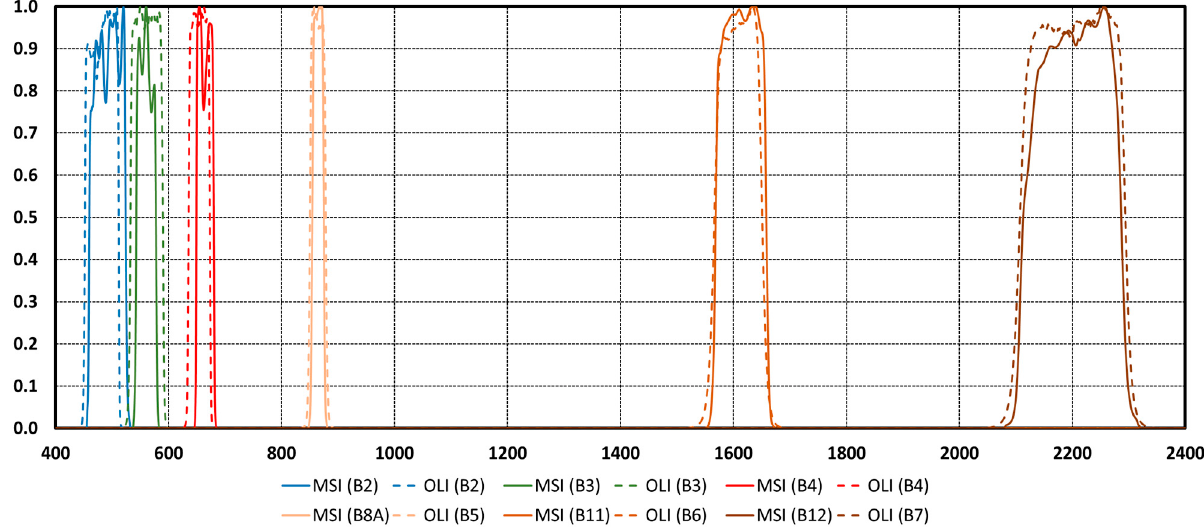
Figure 2. Spectral response functions of Sentinel-2 MSI and Landsat OLI common bands.